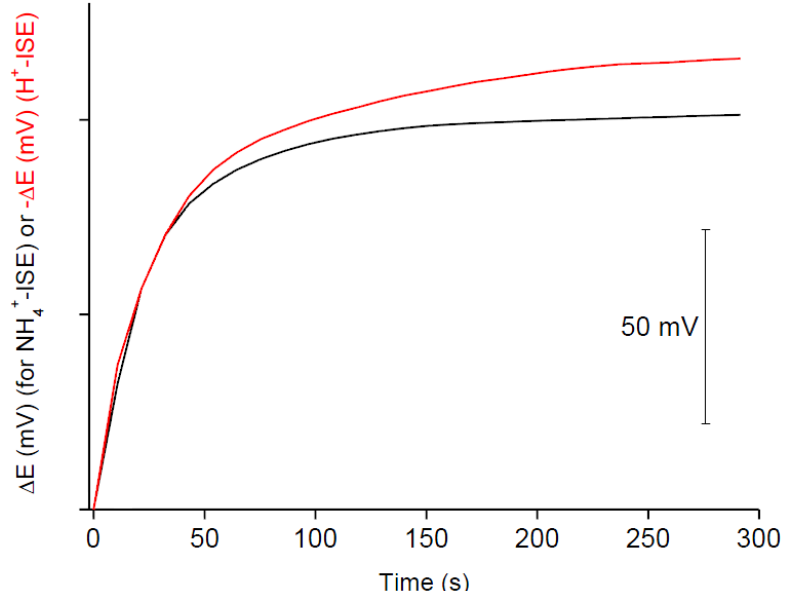
Figure 5. The change of the potential recorded for biosensors containing urease in a cellulose acetate layer for H + -ISE (red line) and for NH 4+ -ISE (black line), following introduction 10 −3 M urea to the unbuffered ( i.e. , DI water-containing) sample. The lines were shifted to give the same starting potentials; for H + -ISE, when the decrease of potential is recorded, the negative potential change was